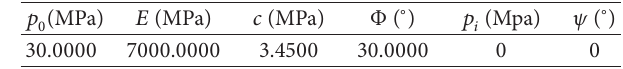
Table 1: Parameters of tunnel model.